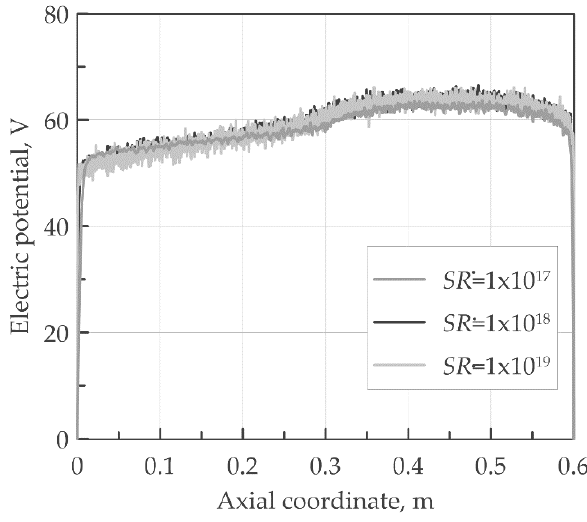
Figure 12. Effect of the ionization source rate on the electric potential at a constant electron temperature of 10 eV.